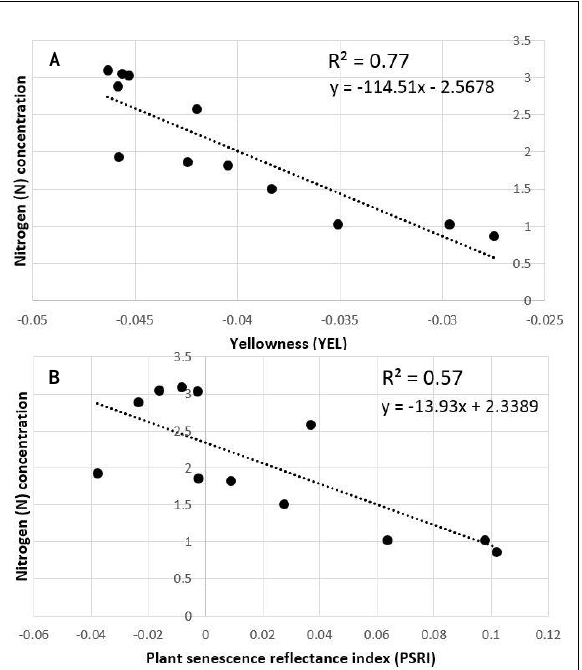
Figure 4. Linear regression of YEL (A) and PSRI (B) to N measurements at sample site U1.1.